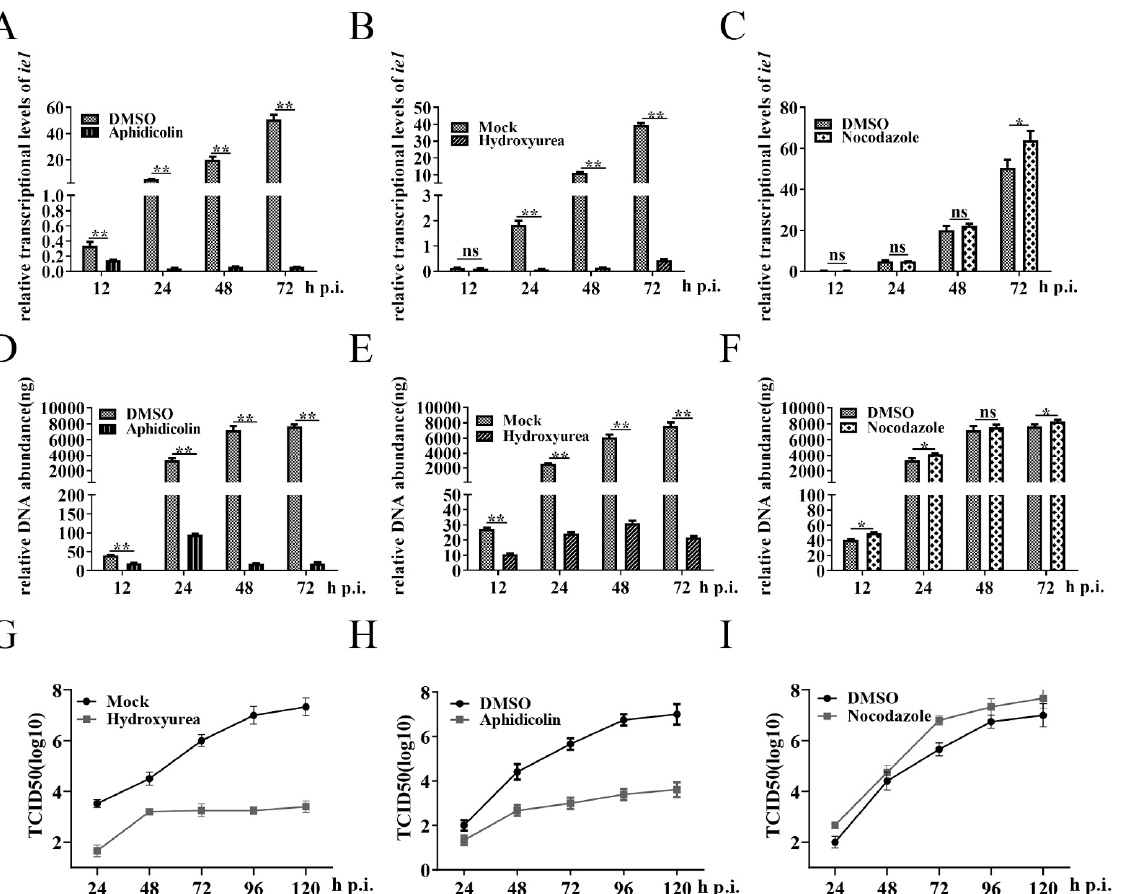
Figure 2. Cells in the G2/M phase create a favorable environment for BmNPV multiplication. The cell cycle of BmN-SWU1 cells was synchronized in the G1 phase by aphidicolin (5 mg/mL, 24 h), in the S phase by hydroxyurea (cells were cultured with 1 mM hydroxyurea for 16 h and without hydroxyurea for 7 h), and in the G2/M phase by nocodazole (10 mg/mL, 24 h). Then, cells were infected with 1 MOI of BmNPV. At 1 h post infection, cells were cultured in fresh culture medium supplemented with aphidicolin, hydroxyurea, and nocodazole at predetermined concentrations. ( A – C ) The mRNA levels of ie1 in aphidicolin-, hydroxyurea-, or nocodazole-treated cells were analyzed using qRT-PCR. ( D – F ) Viral genome copies were detected in aphidicolin-, hydroxyurea-, or nocodazole-treated cells. ( G – I ) Viral titer analysis of progeny viruses in aphidicolin-, hydroxyurea-, or nocodazole-treated cells by TCID50. The data are presented as the mean ± SD of three independent experiments. Statistical differences were analyzed with Student’s t -test ( ns p ≥ 0.05, * p < 0.05 and ** p < 0.01).